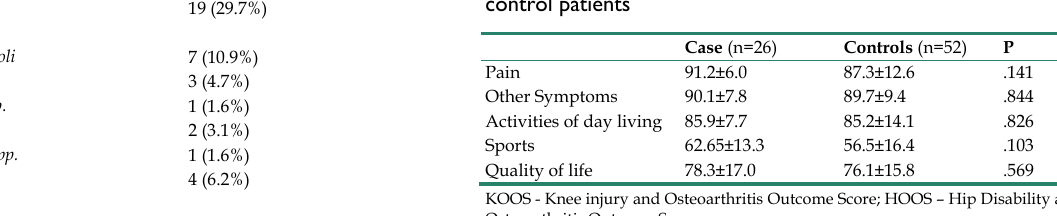
Table 3. Final functional results (HOOS/KOOS) of infected